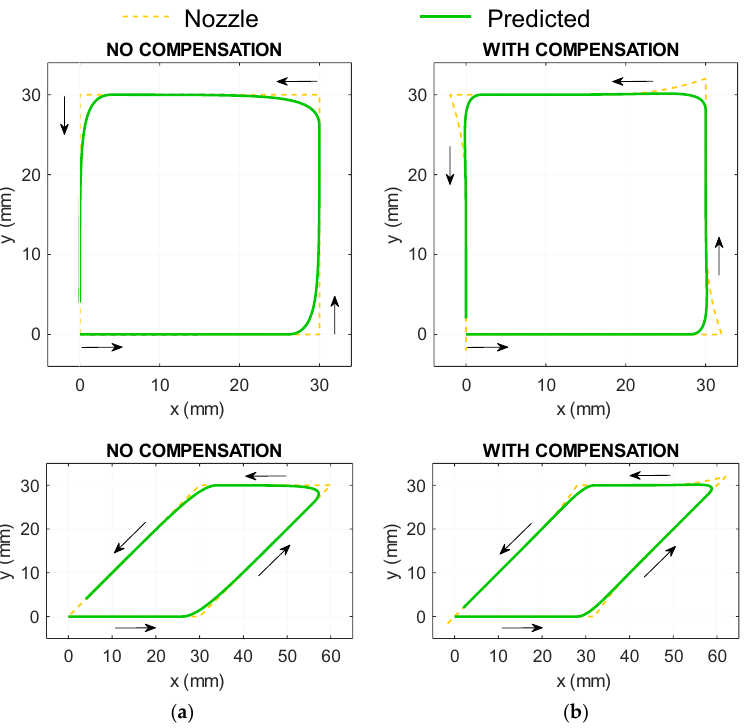
Figure 8. Simulated nozzle path without ( a ) and with ( b ) compensation, starting from (0,0) and printed following the arrows), showing the predicted raster path. The proportional and integral gains used by the PI controllers in ( b ) are K P = 1.5 and K I = 2.5.